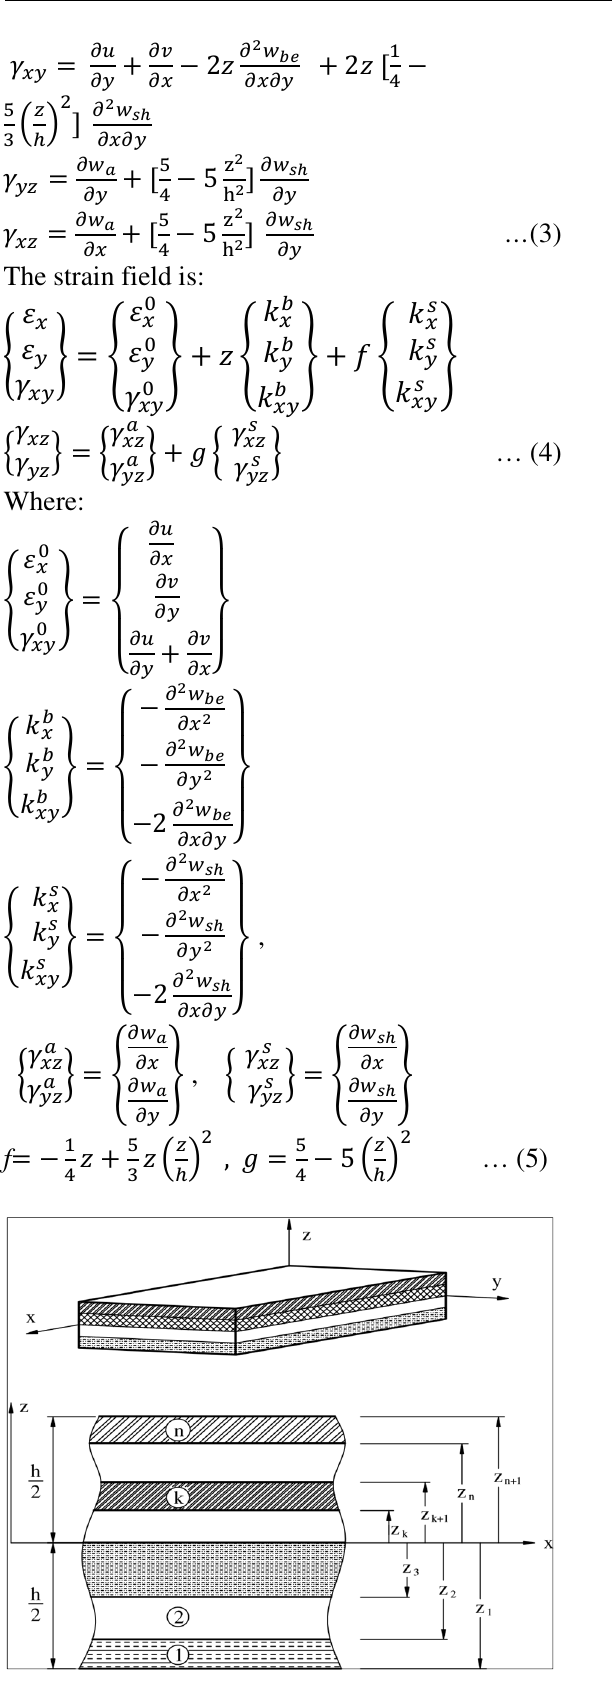
Fig. 1. coordinate system of laminated